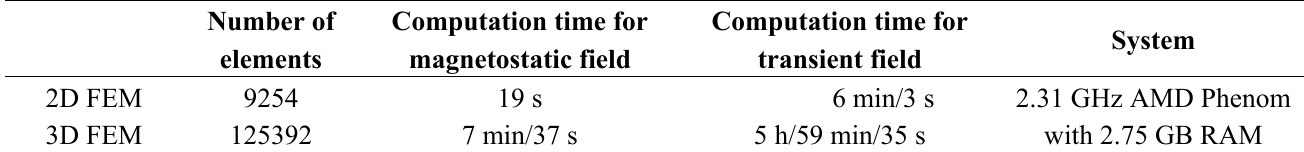
Table 1. Comparison of 2D FEM and 3D FEM.